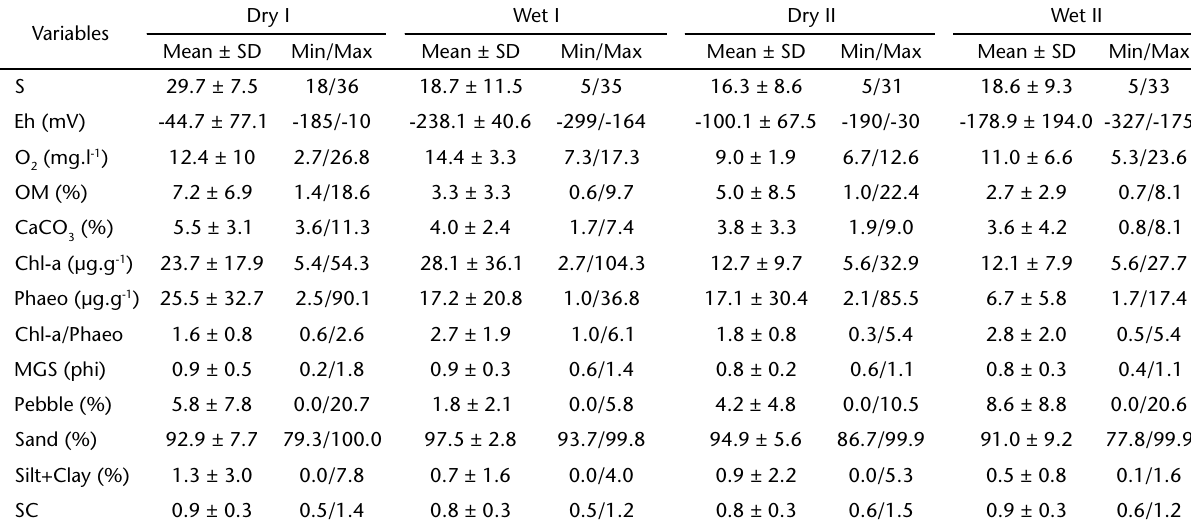
Table II. Mean and standard deviation (SD) values of environmental variables per sampling period in Saquarema-Jaconé lagoon system.